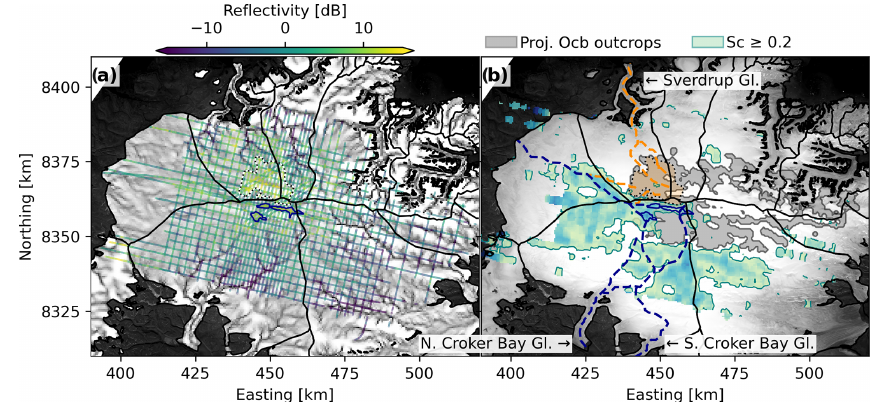
Figure 6. Hydrological pathways. (a) Modeled potential subglacial hydrological pathways (grayscale) beneath DIC, overlain with the basal reflectivity. (b) Landsat image overlain with areas where the Ocb unit is projected to outcrop beneath the ice (gray), areas of elevated specularity content Sc (increasing values with darker color), and the main water routes where brine from the subglacial lakes (blue) and brine network (orange) potentially propagates